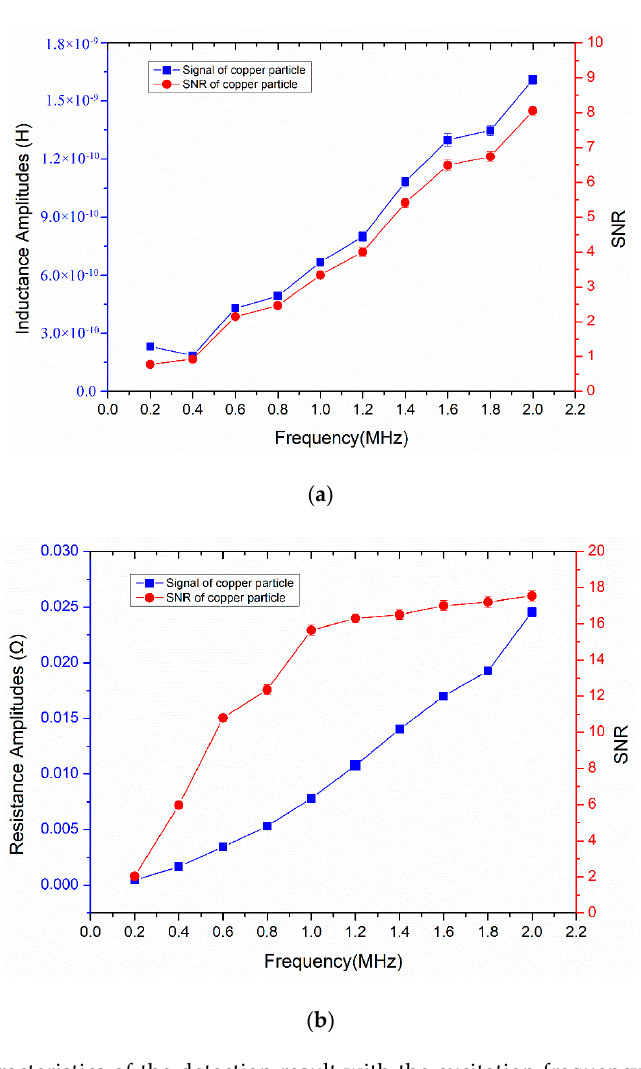
Figure 5. The characteristics of the detection result with the excitation frequency: ( a ) the average inductance amplitude and signal-to-noise ratio (SNR) of a 120 μ m copper particle at different frequencies; ( b ) the average resistance amplitude and SNR of a 120 μ m copper particle at different frequencies.